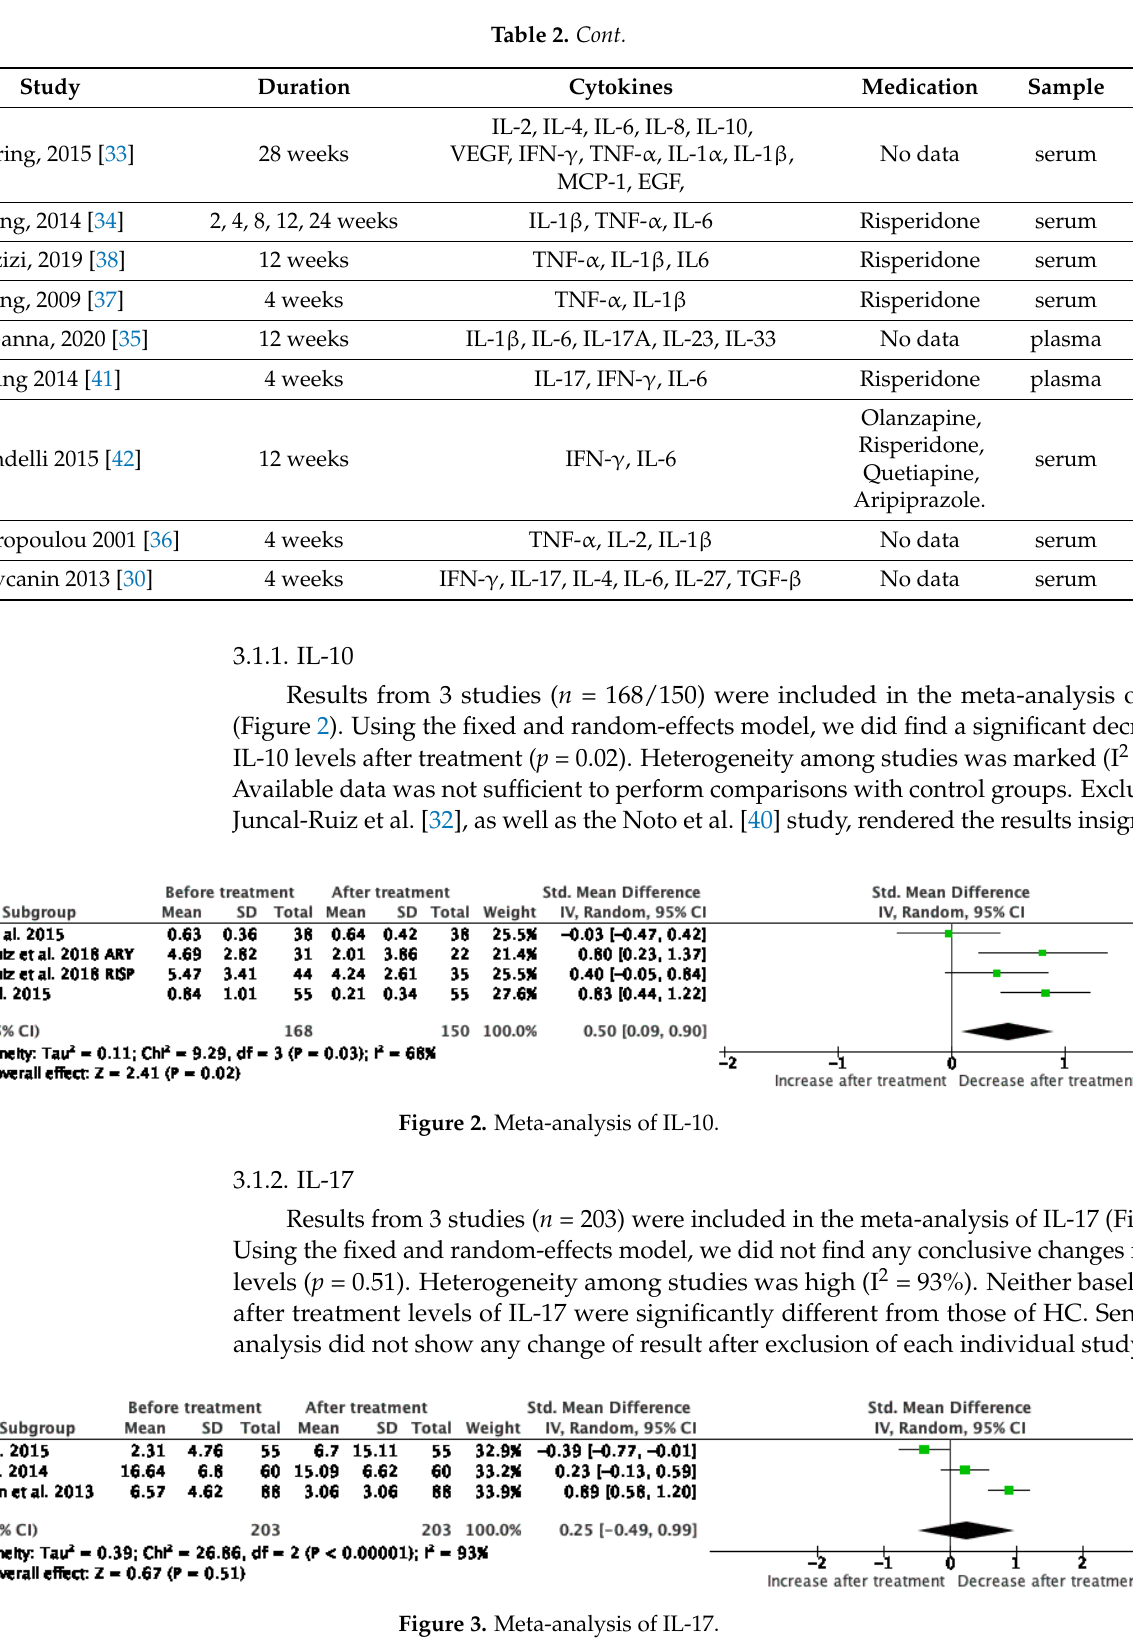
Figure 3. Meta-analysis of IL-17.